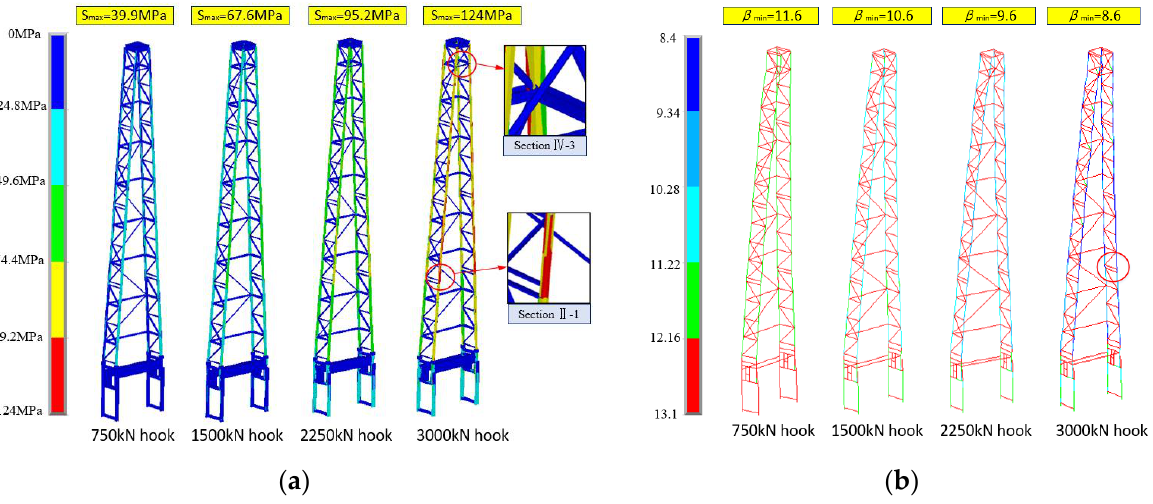
Figure 5. The variation of the stress and reliability index with hook load increasing. ( a ) Stress contour plot. ( b ) Reliability index contour plot.